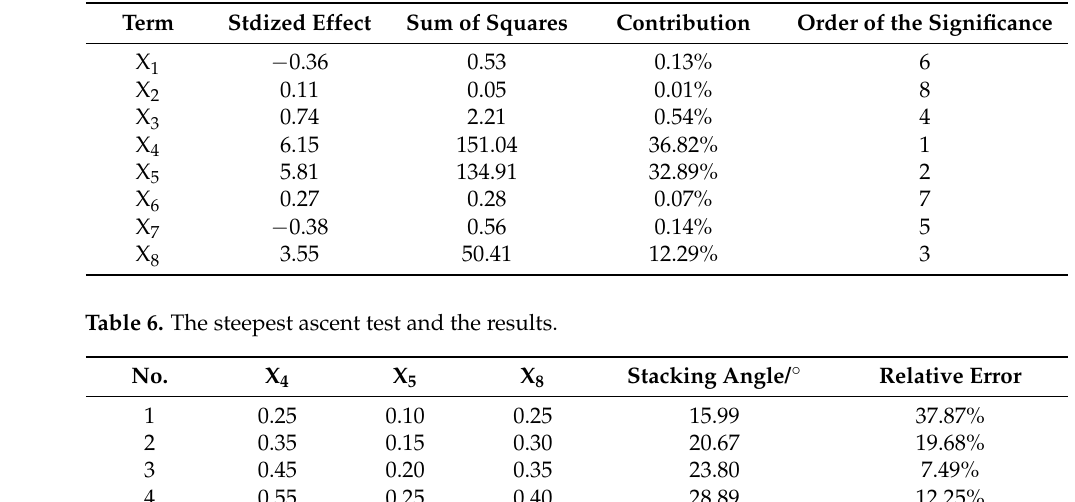
Table 5. The effects analysis of the experimental results.